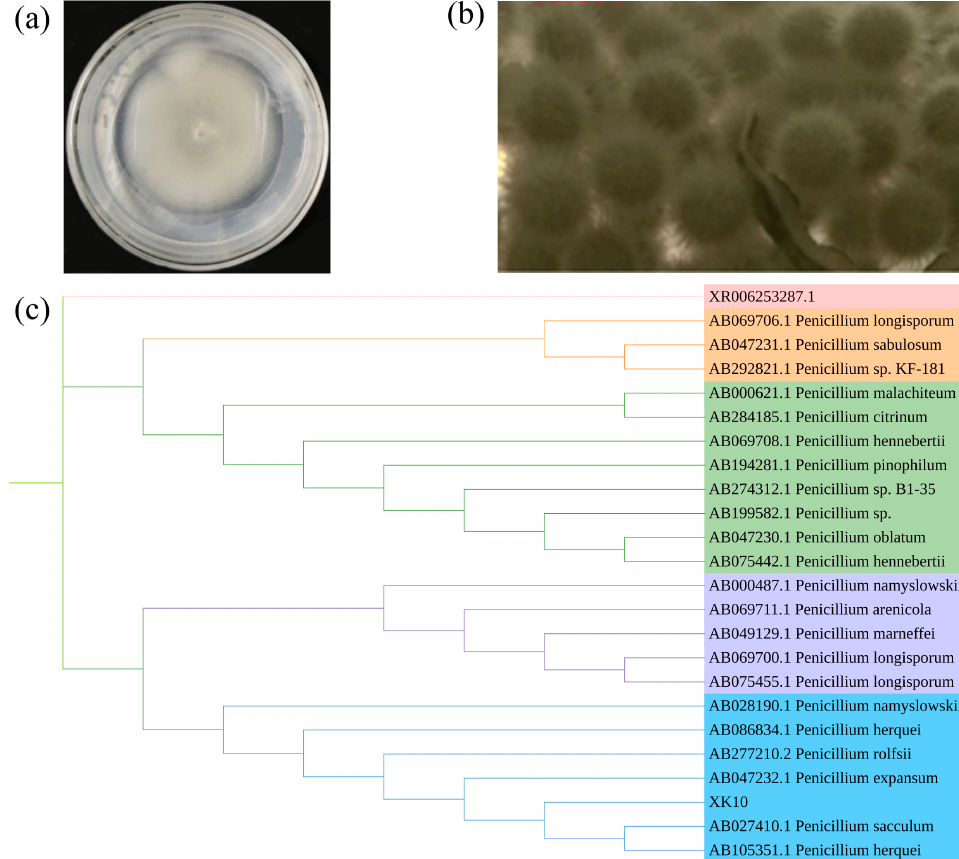
Figure 2. The morphology and phylogenetic tree of XK10. ( a ) Morphology of XK 10. ( b ) Morphology of mycelial pellets of XK10. ( c ) Phylogenetic tree of XK10.